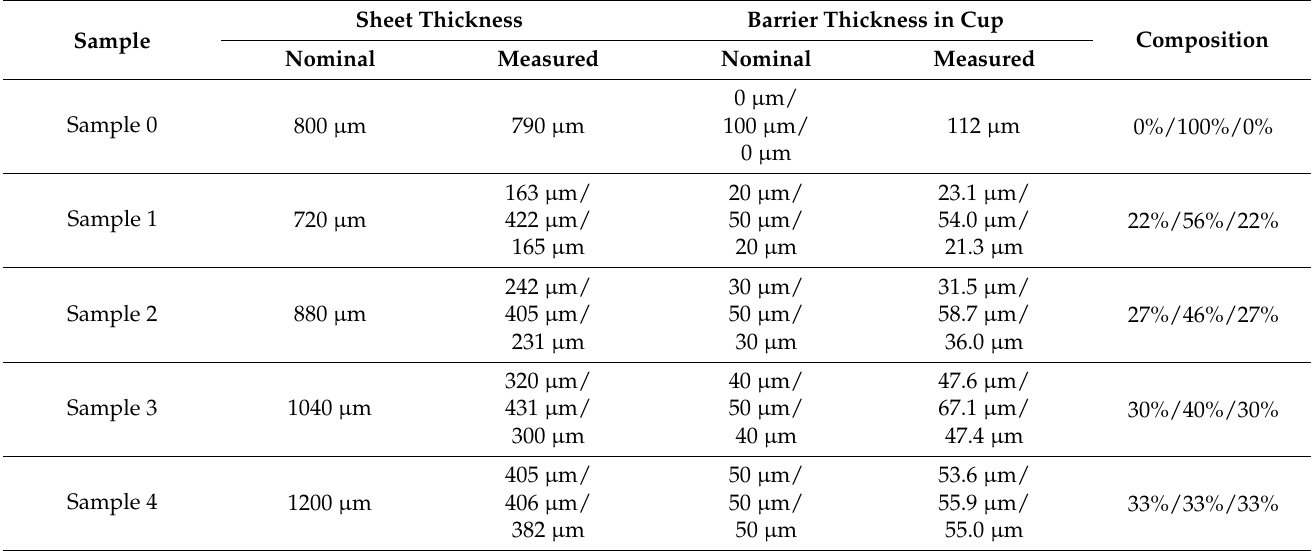
Table 7. Nominal and measured thicknesses of the sheets and yogurt